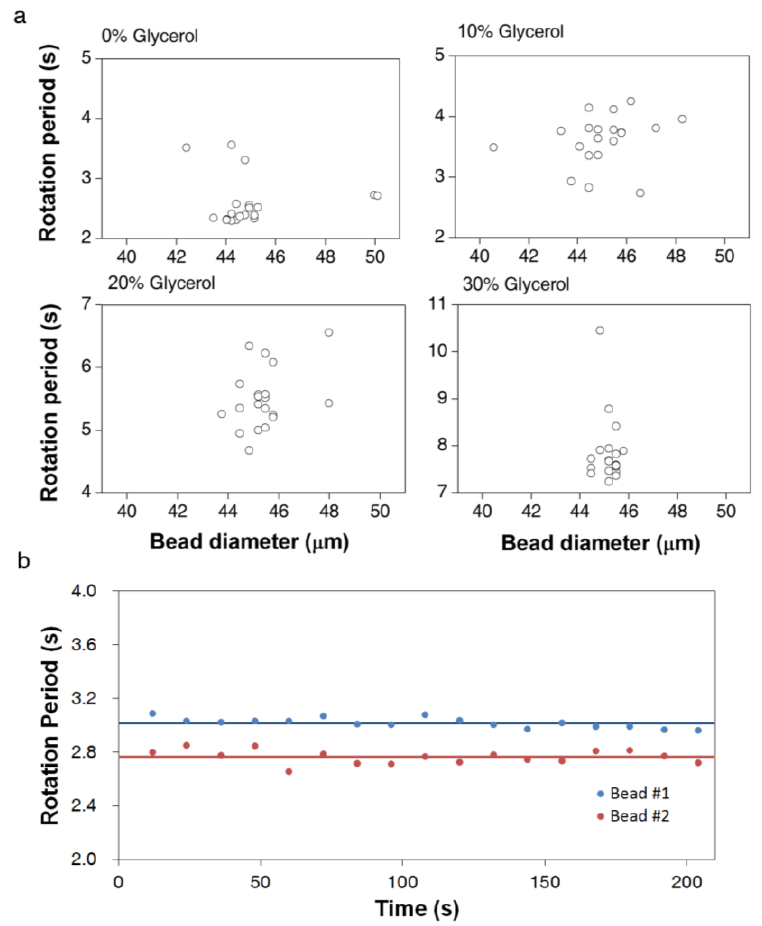
Figure 2. Reproducibility of AMBR viscosity measurements at 100 Hz driving frequency. ( a ) Rotation period measurement of 20 independent beads in the same solution plotted against the optically measured bead size of each bead. ( b ) The rotation periods of two examples of 45 µm beads observed over time in the same solution. The rotation periods are calculated over a 12 s period and plotted in the graph. The average values are for 17 sequential